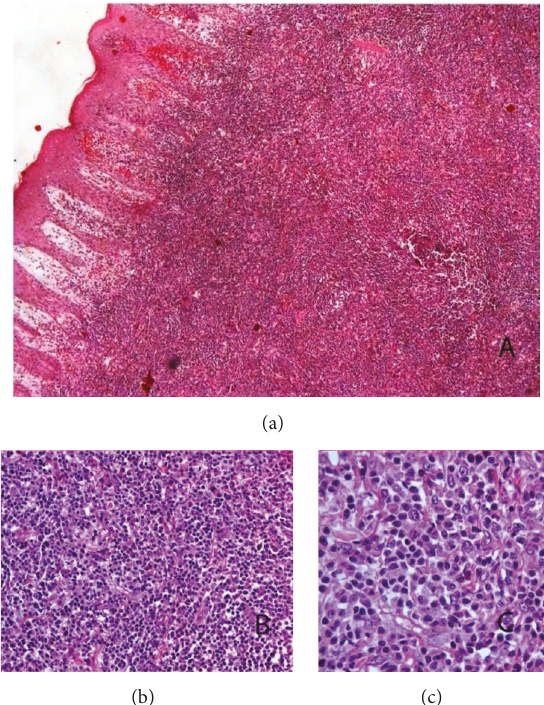
Figure 2: Histology revealed a diffuse lymphocytic infiltration in the reticular dermis by small, medium, and large sized lymphocytes, some of which with anaplastic nuclei, accompanied by a variable number of neutrophils and histiocytes (hematoxylin-eosin stain x 20 (a), x 40 (b), x 60 (c)).